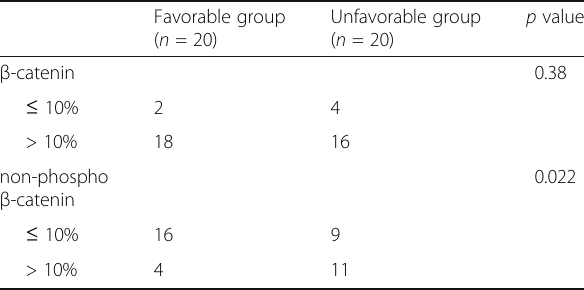
Table 4 Nuclear expression of β -catenin and non-phospho β -catenin on cut off value of 10% setting. Relationship with clinical outcome of COX-2 inhibitor therapy